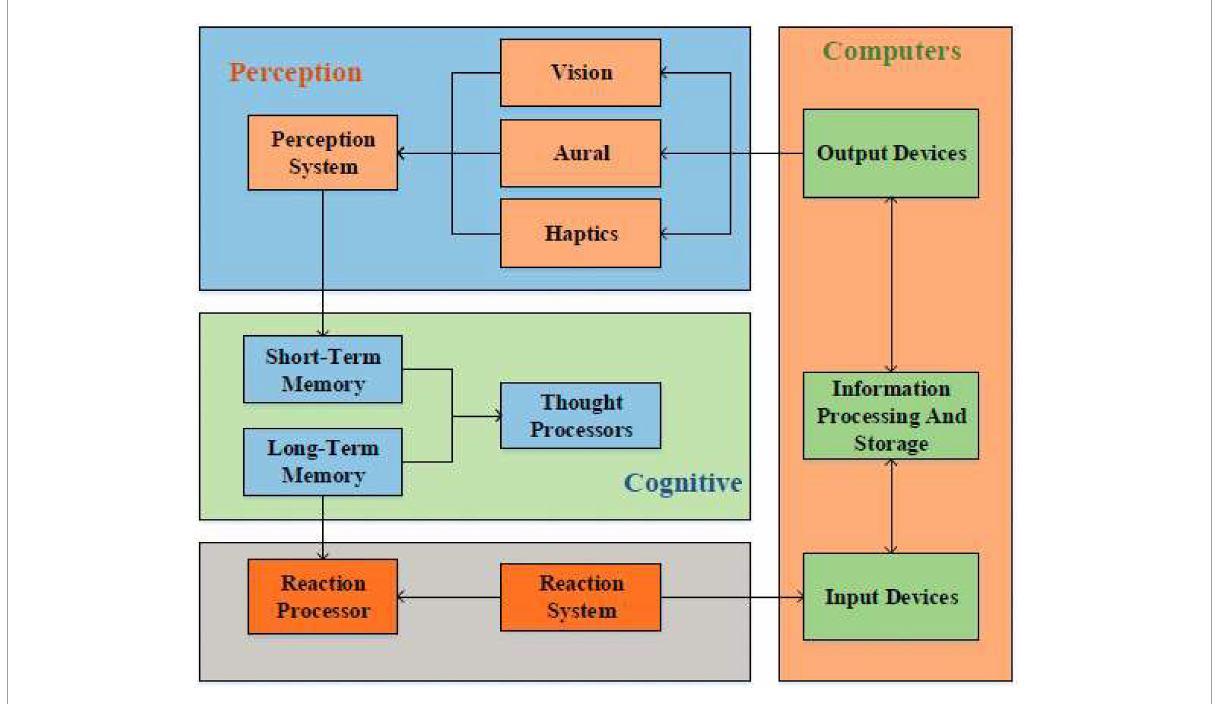
FIGURE1 Information processing process of the human-computer interaction (HCI)